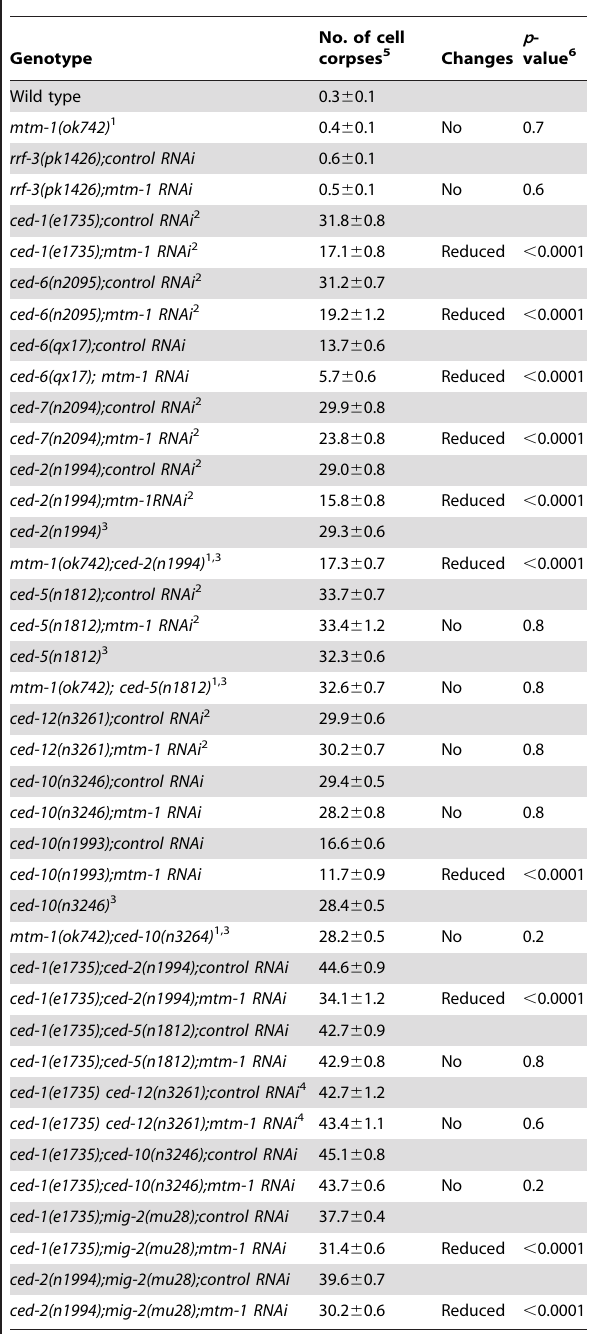
Table 1. mtm-1 negatively regulates cell corpse engulfment through ced-5/12/10